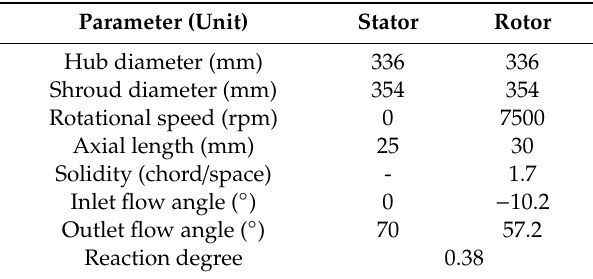
Table 2. One-dimensional thermodynamic